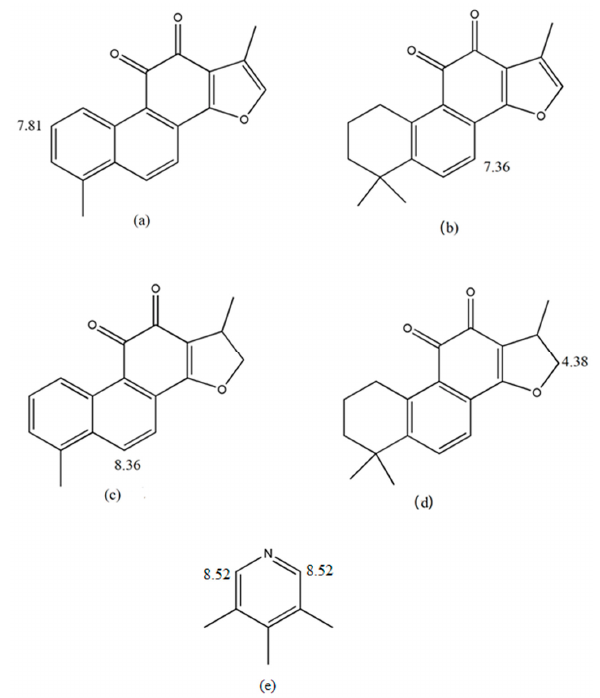
Figure 1. Chemical structures of Tan I ( a ), Tan IIA ( b ), DTS ( c ), CTS ( d ) and 3,4,5-trichloropyridine ( e ) in SMB. (The numbers in the figure represent the chemical shifts of the marked peaks of the NMR spectrum of each compound, unit is ppm).